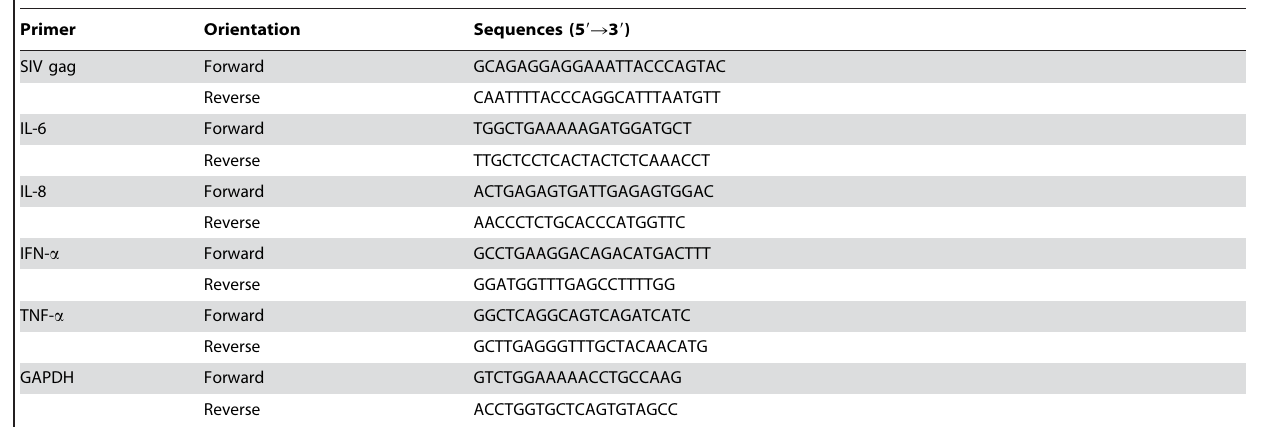
Table 2. Primer Pairs for Real-Time RT-PCR.